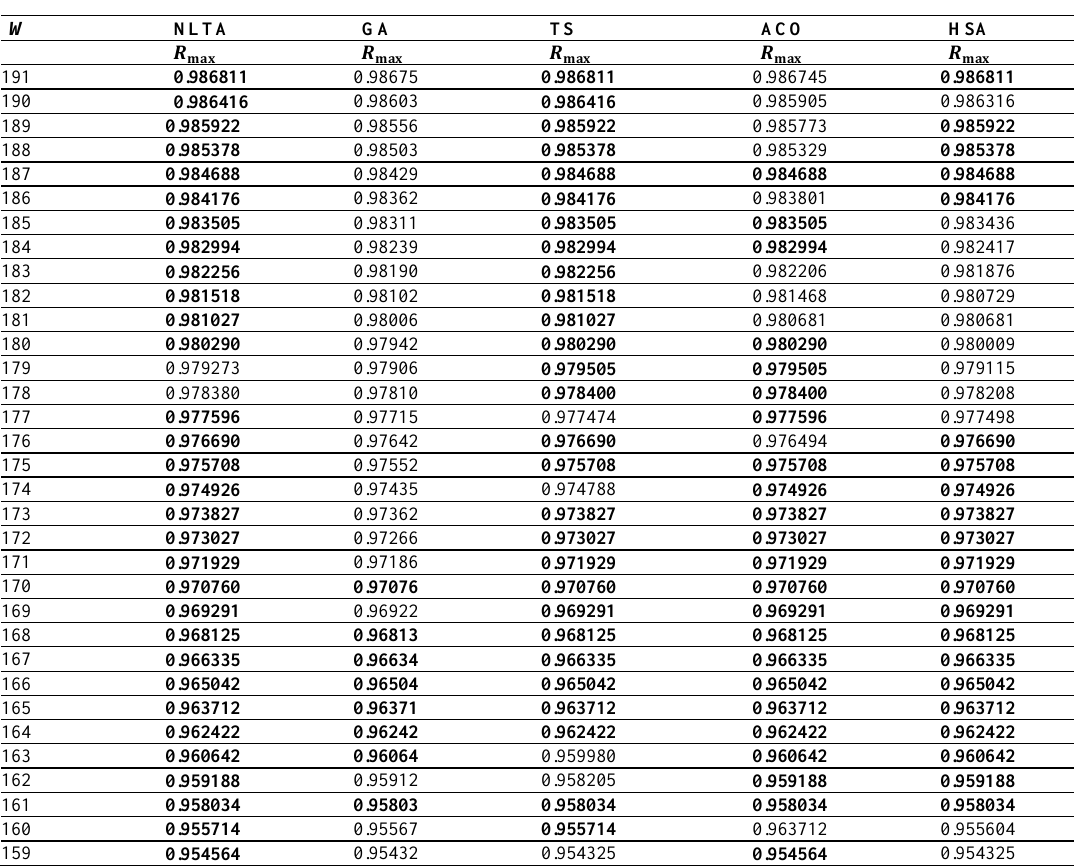
Table 4. Comparison of the NLTA and the best known